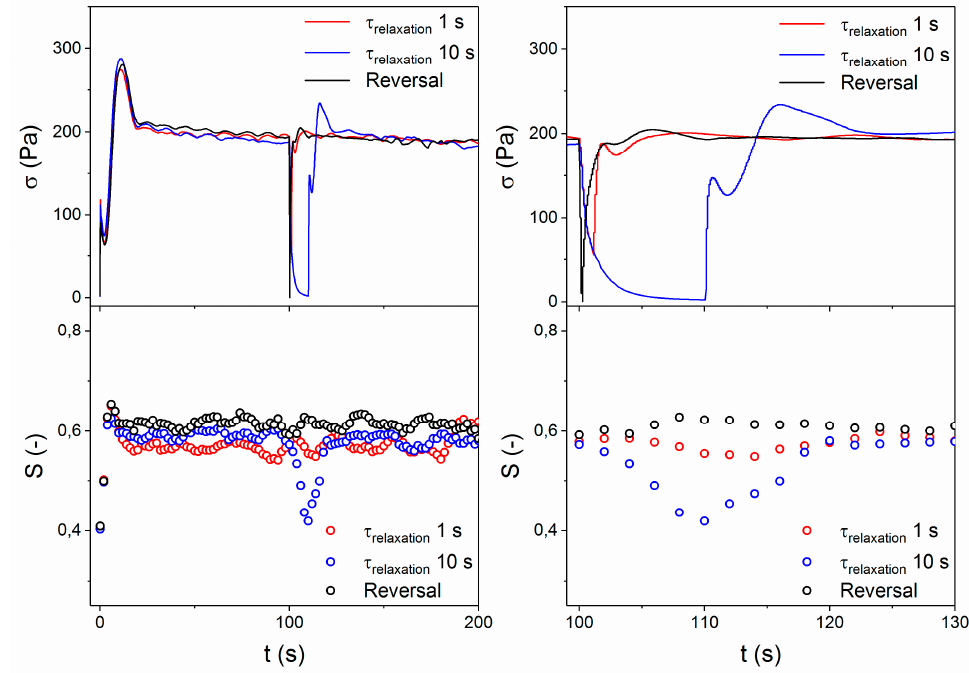
Figure 11. Development of shear stress and orientation parameter as a function of time for controlled relaxation experiments. The applied shear rate was 10 s − 1 at 150 °C.